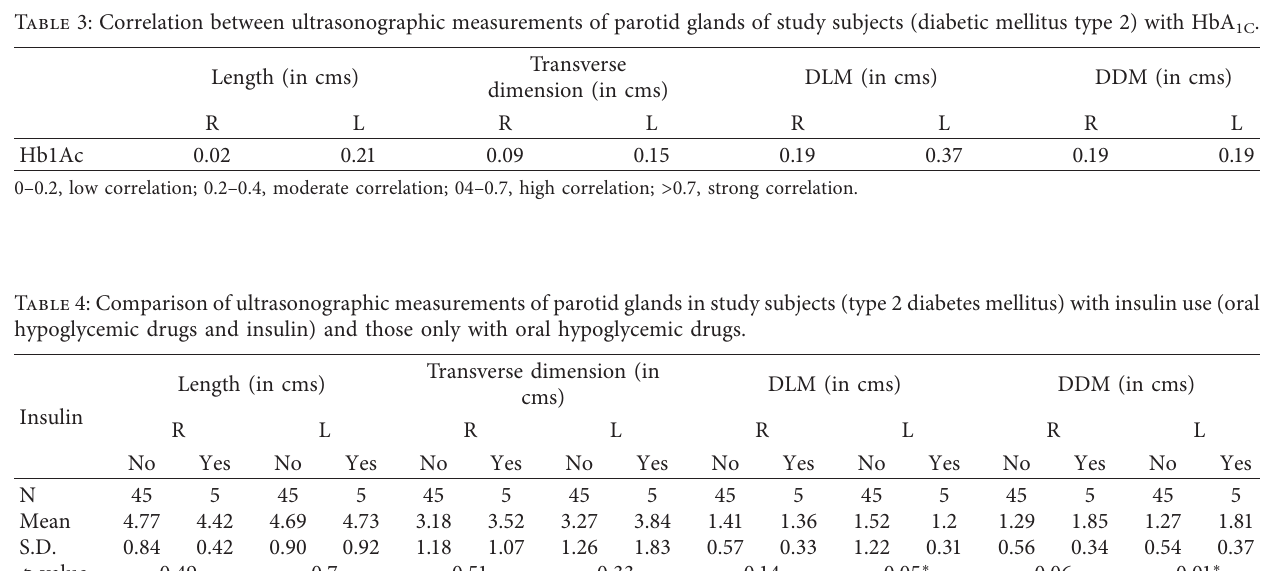
0.14 0.05 ∗ 0.06 0.01 ∗